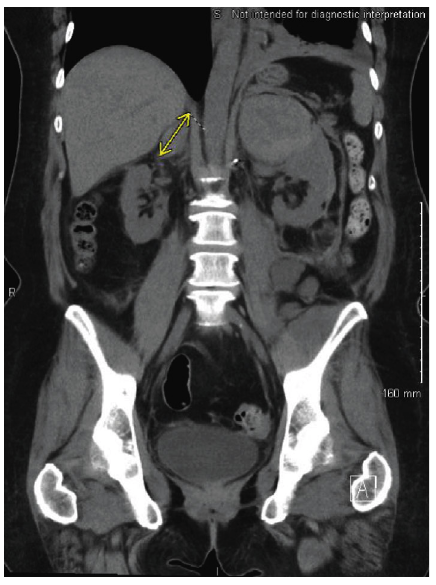
Figure 2: Demarcation of right adrenal